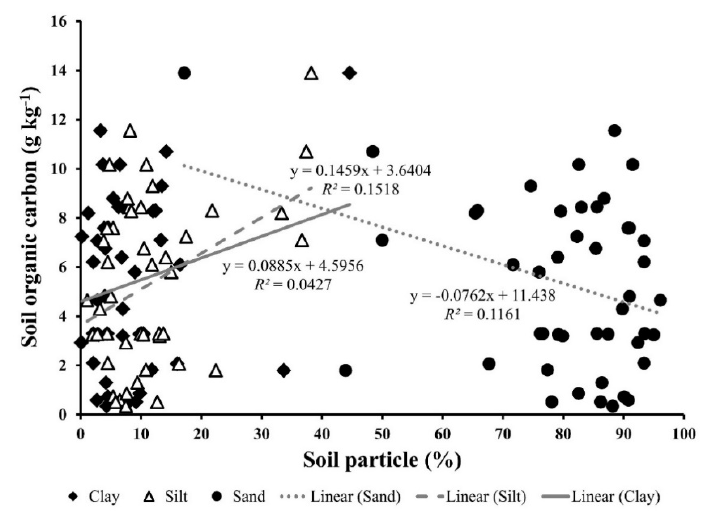
Figure 4. Overview on soil organic carbon (g kg − 1 ) of paddy fields from Northeast Thailand ( n = 45) (within the range of 0–40 cm depth) [45,50–52,54,57,61,63,65,66,68,69,81,82].